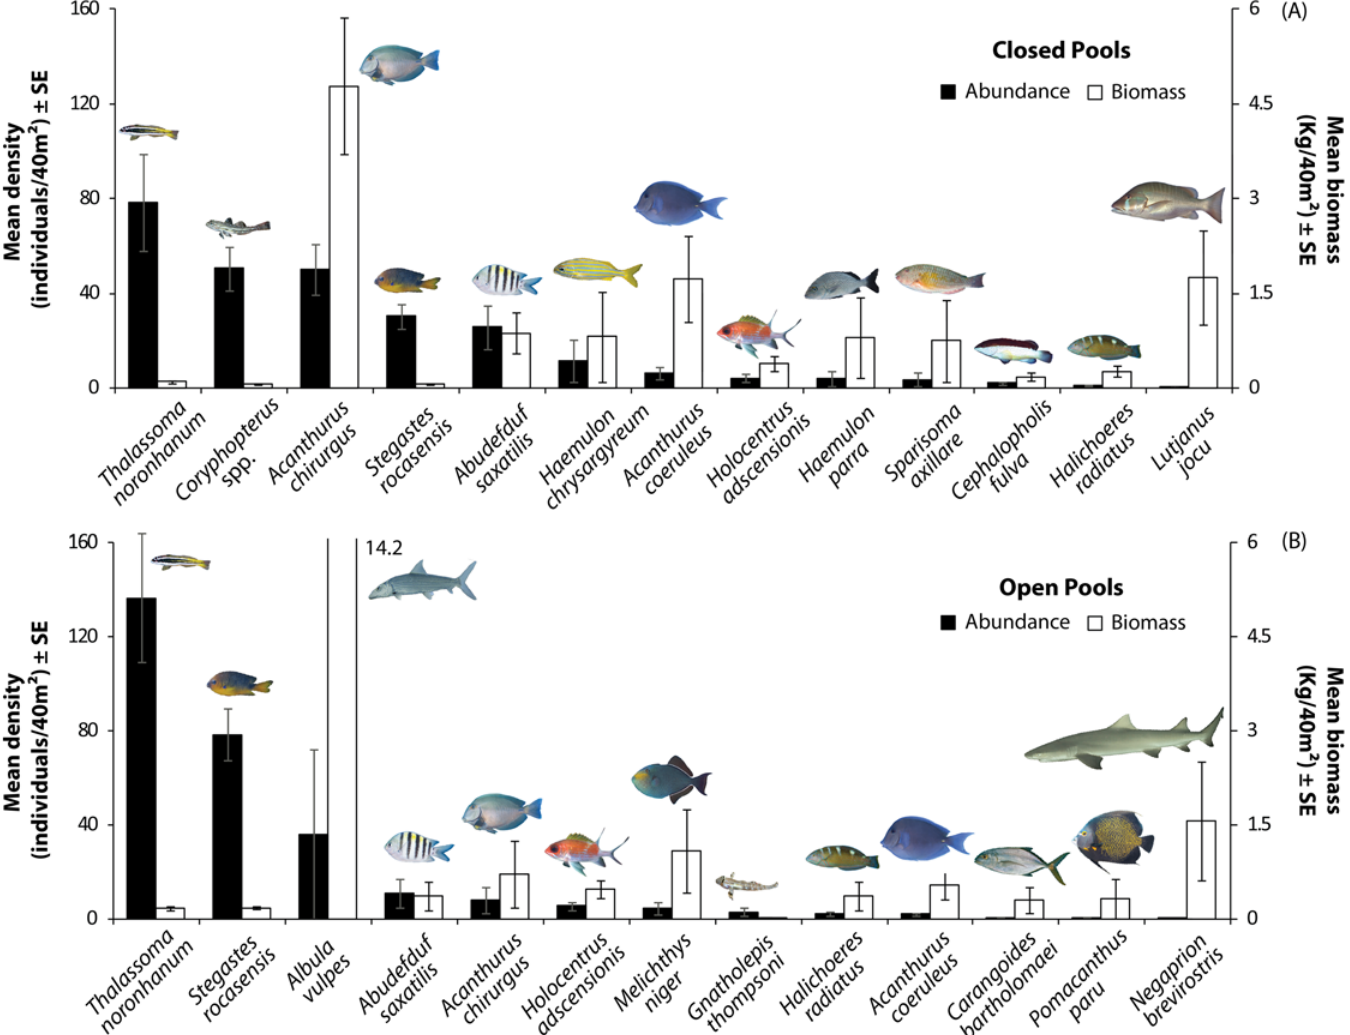
Fig 3. Density and biomass of reef fishes in open and closed pools at Rocas atoll. Displayed species were chosen based on a ranking combining density and biomass. Error bars represent standard